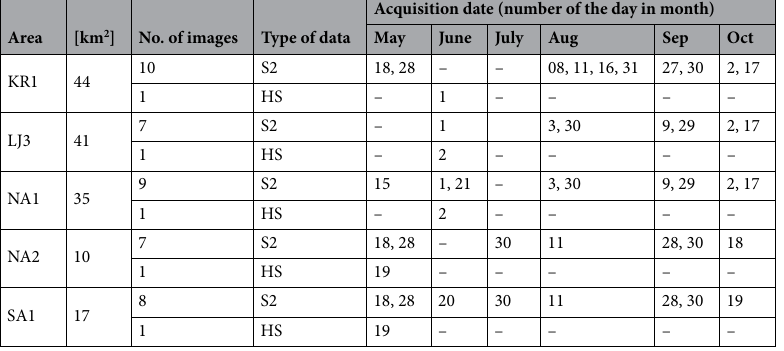
Table 3. The number and date of acquired images in